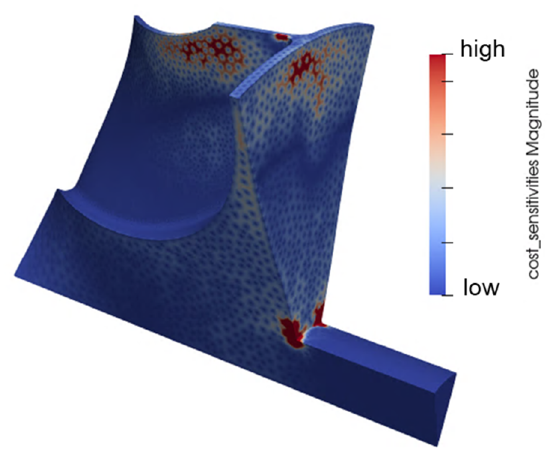
Figure 22. Sensitivities of the thermo-mechanical constraint w.r.t. grid coordinates.